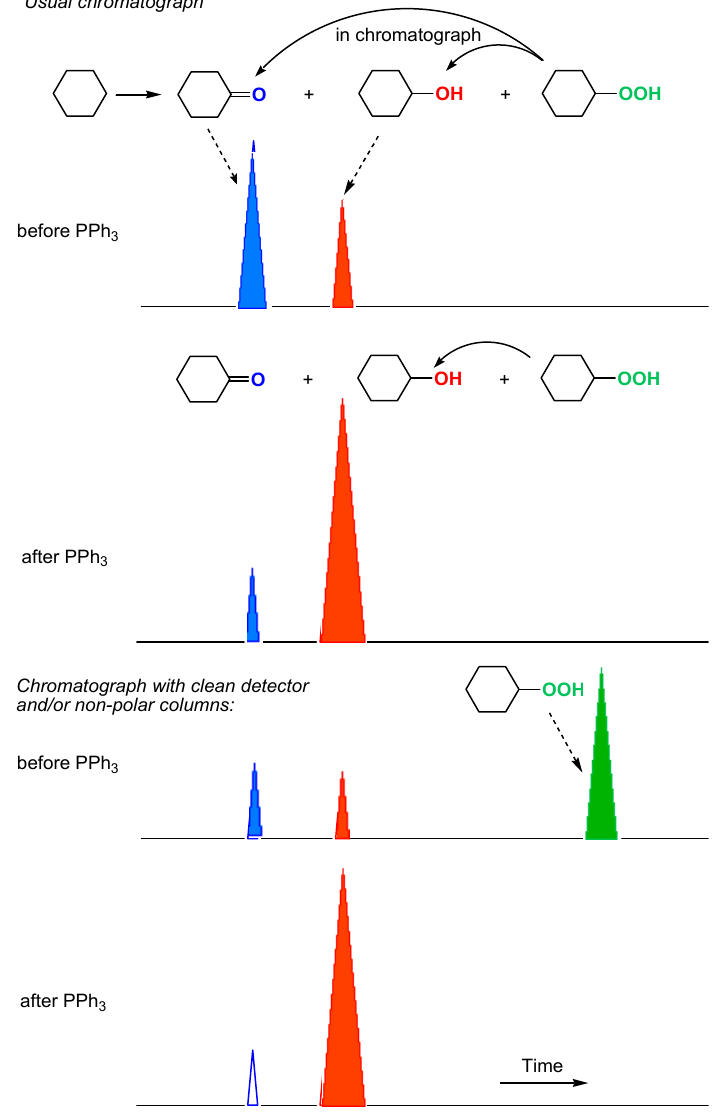
Figure 16. Detection of alkyl hydroperoxide ROOH by GC.